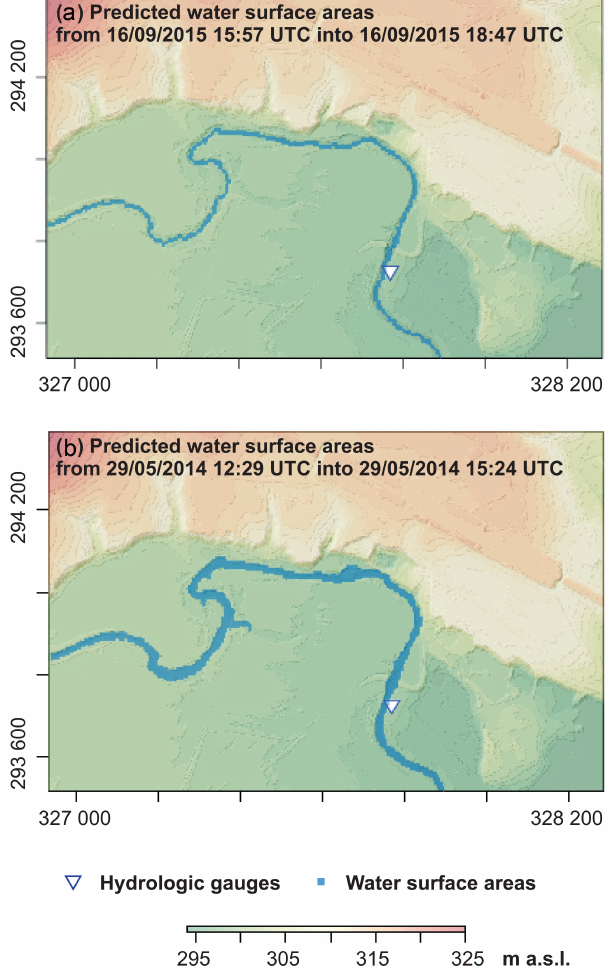
Figure 1. Predictions of water surface areas derived by the HydroProg–FloodMap solution (Niedzielski et al., 2015) extracted from the real-time web map service experimentally implemented for Kłodzko County: (a) low-flow situation, (b) high-flow situation.